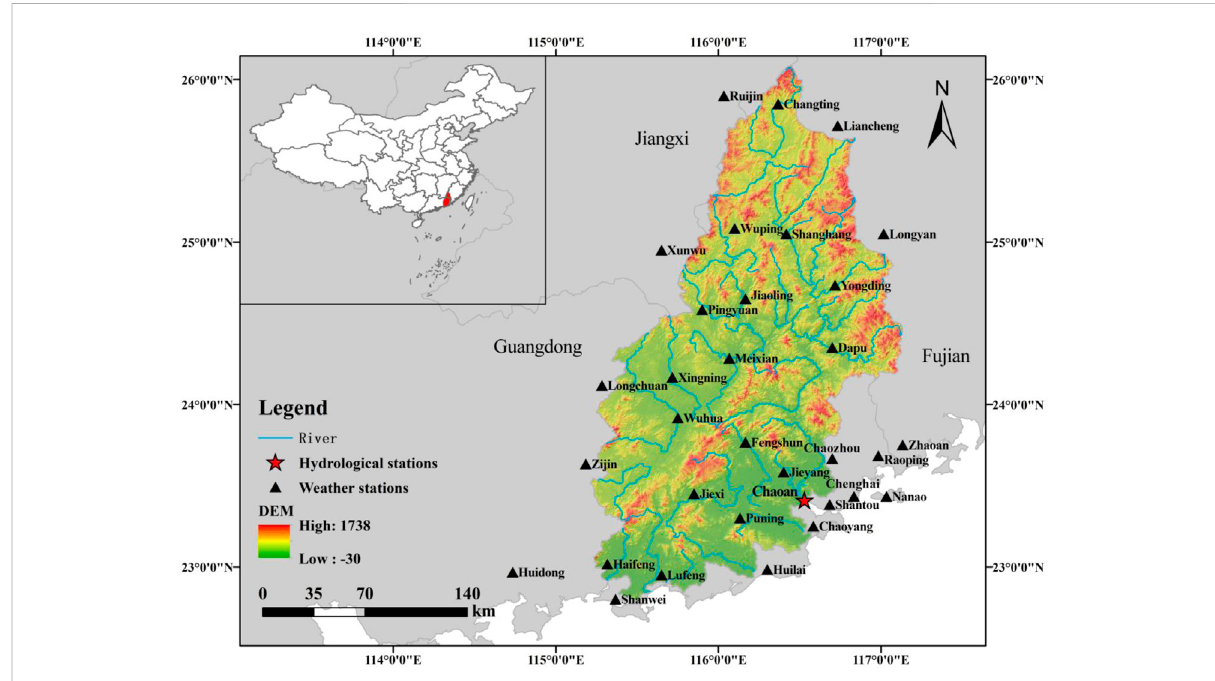
FIGURE 1 Location and distribution of meteorological stations in the Hanjiang River Basin,